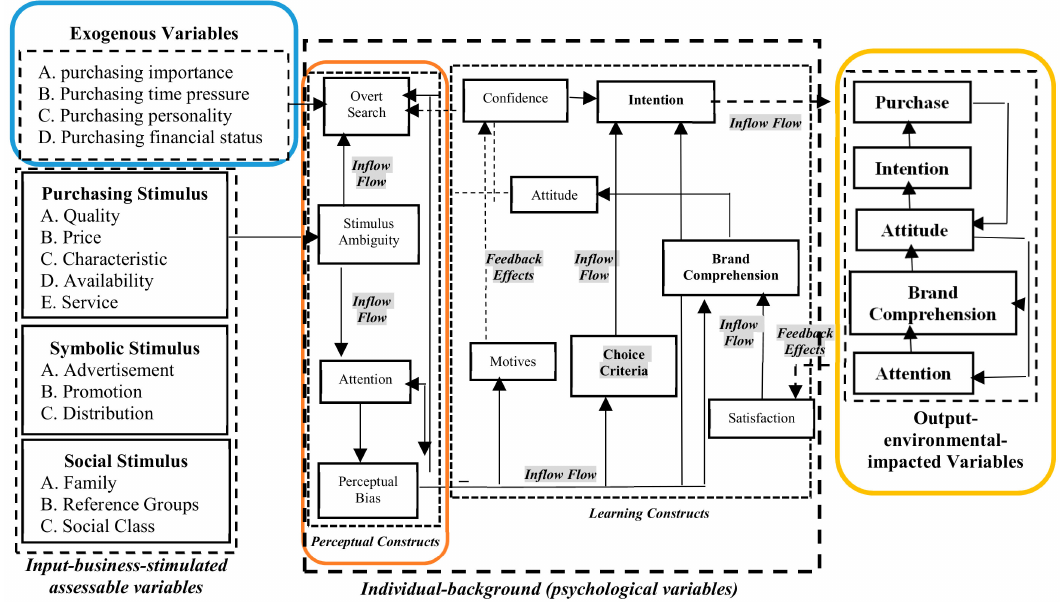
Figure 3. Essential Purchasing Procedures of HS